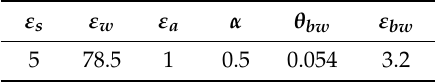
Table 3. Parameters of theoretical calibration equations of Dobson et al. [36], Roth et al. [34], and Maxwell-De Loor [37].